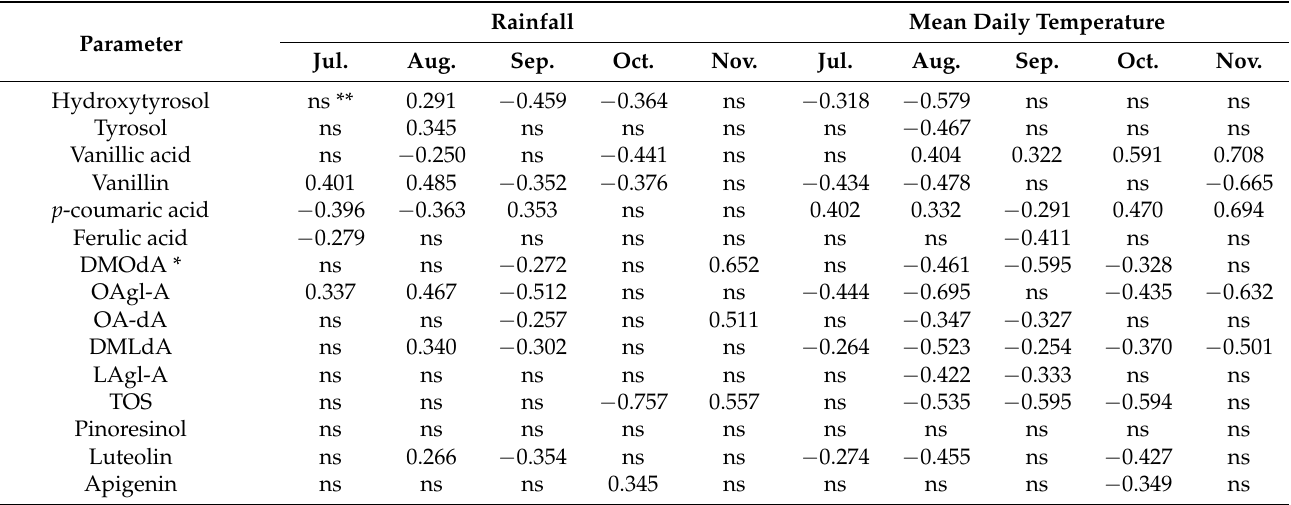
Table 3. Correlation factors of phenolic composition of virgin olive oil and climatic parameters (rain- fall and mean daily temperature; Table S1) in the period of intensive olive fruit growth and